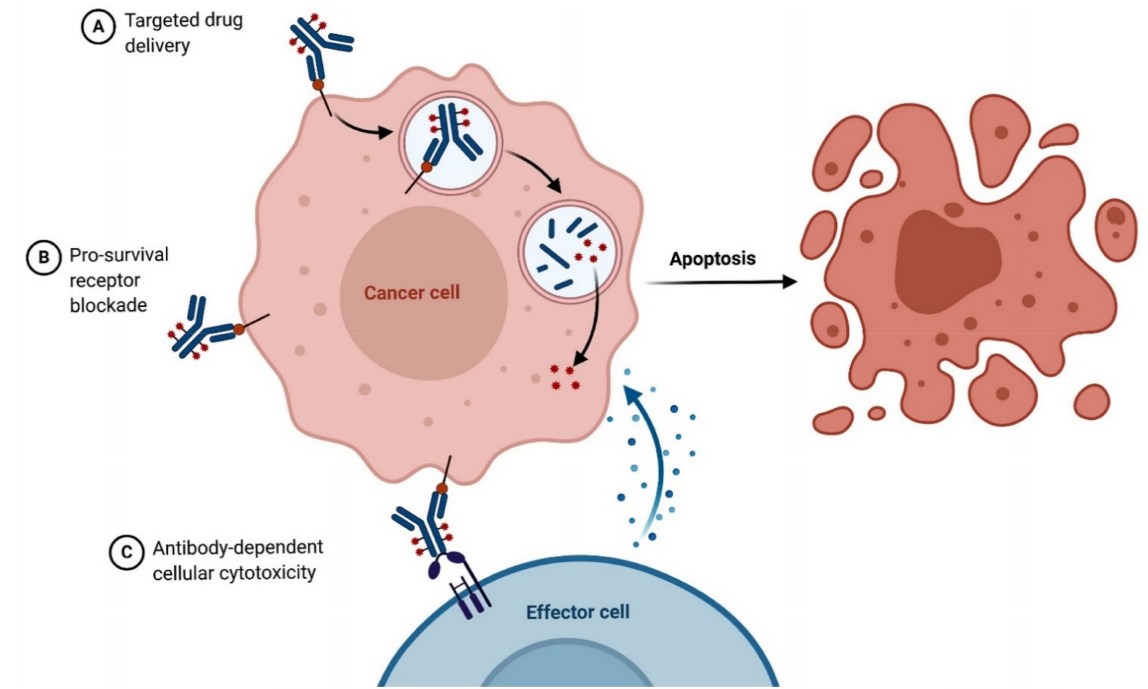
Figure 4. A diagram illustrating the mechanism of action of Antibody-Drug Conjugate (ADC) in a cancer cell. ( A ): High- affinity Antibody binds to the drug, forming ADC, entering the double lipid-membrane layer of the cell to cause cell death. ( B ): ADC binds to the pro-survival receptor of cancer cells, inhibiting its function, commencing apoptosis. ( C ): ADC binds to both the membrane-surface antigen of the cancer cell and an effector cell in the immune system, inducing cellular cytotoxicity lysing the cancer cells. The figure was created with BioRender.com (Accessed on 1 February 2021) and was exported under a paid